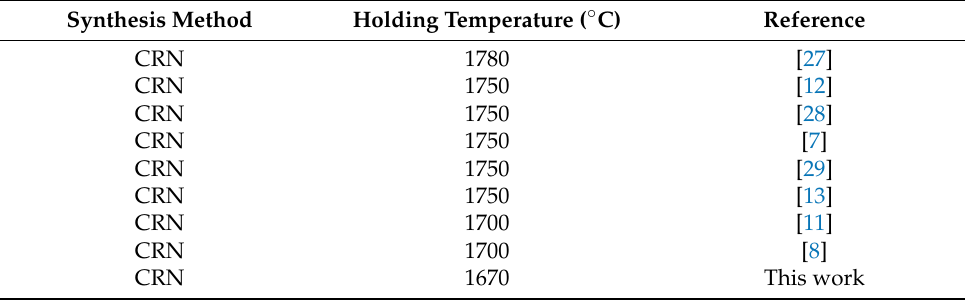
Figure 7. XRD patterns of mixed powder (0 wt% and 5 wt% dispersants) after heating for 1 h at 1670 °C. Table 1. Comparison of synthetic parameters of AlON powder.